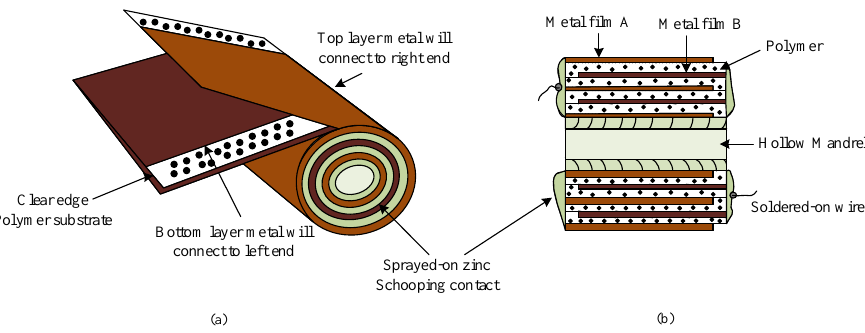
Figure 8. The constructions of the metallized polypropylene film capacitor (MPPF-Cap): ( a ) the cylinder construction and ( b ) the cross section of the cylinder shape.